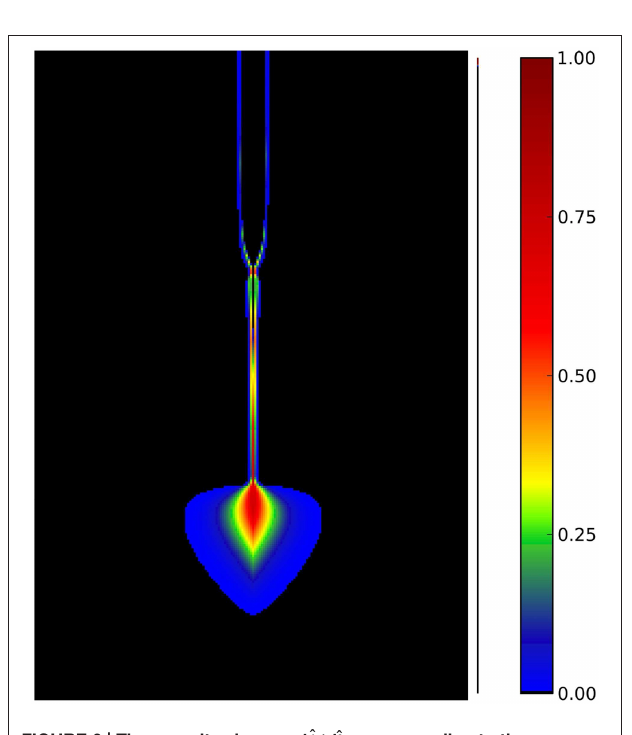
Undulations in different pipes are spatially correlated, which suggests the presence of at least three layers in this system. The dark rims along the perimeter of the pipes are most likely the result of clay and iron oxide accumulation due to the illuviation processes [57]. The clay particles are transferred by water from the upper parts of the soil and then flocculated at the clay-limestone boundary, where the pH changes from mildly acidic to alkaline. Such rims are commonly seen in solution pipes in which the infill is still present [7,